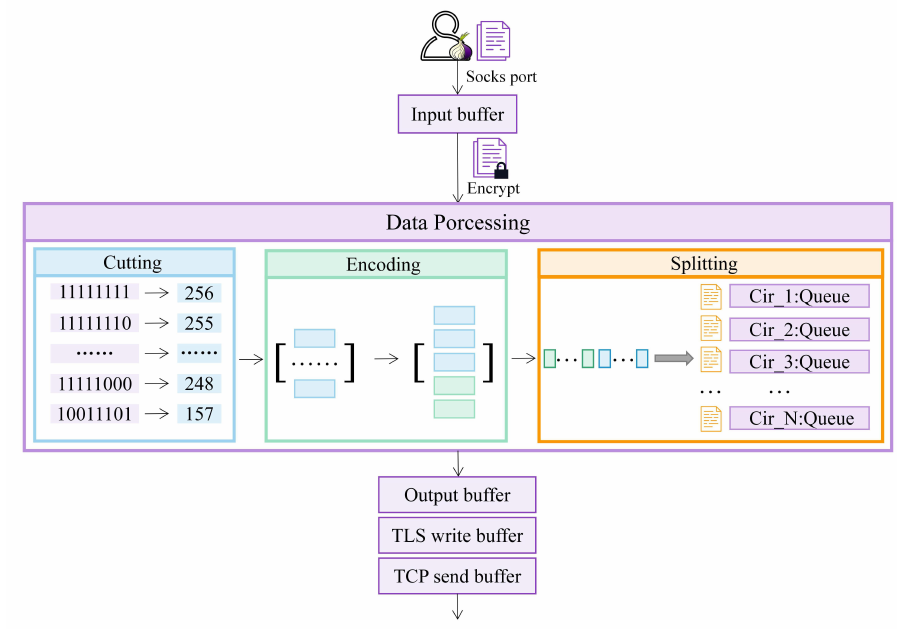
Figure 3. Sender data